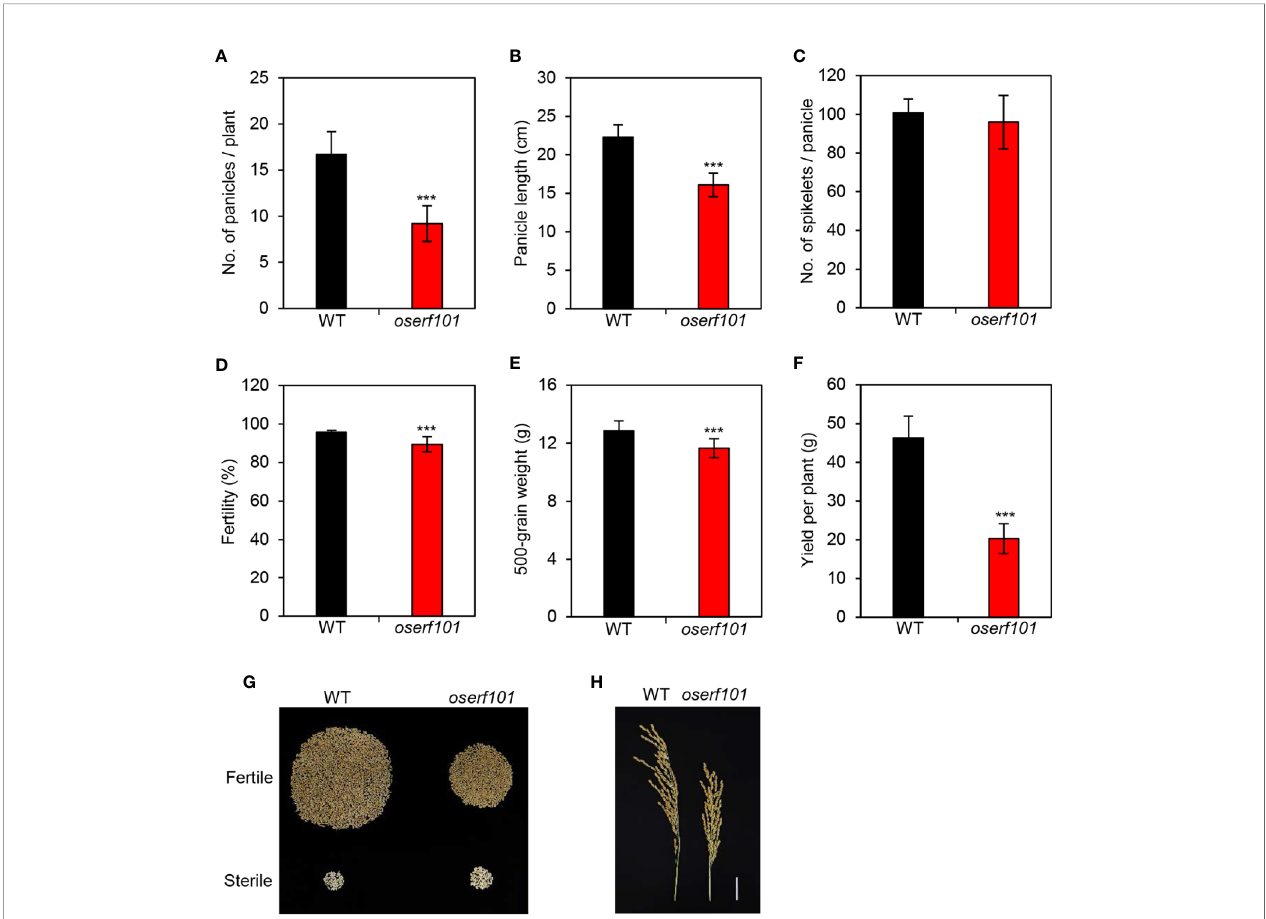
FIGURE 6 | Agronomic traits measured in the oserf101 mutant. Agronomic traits were compared between the WT and oserf101 plants after harvest in the autumn. (A) Number of panicles per plant. (B) Panicle length. (C) Number of spikelets per panicle. (D) Fertility. (E) 500-grain weight. (F) Grain yield per plant. (G) The relative abundances of fertile and sterile spikelets in the WT and oserf101 plants. (H) Phenotype of panicles. Mean and standard deviations were obtained from 10 rice plants. Asterisks indicate a signi fi cant difference between the WT and oserf101 mutants (Student ’ s t -test, *** p <